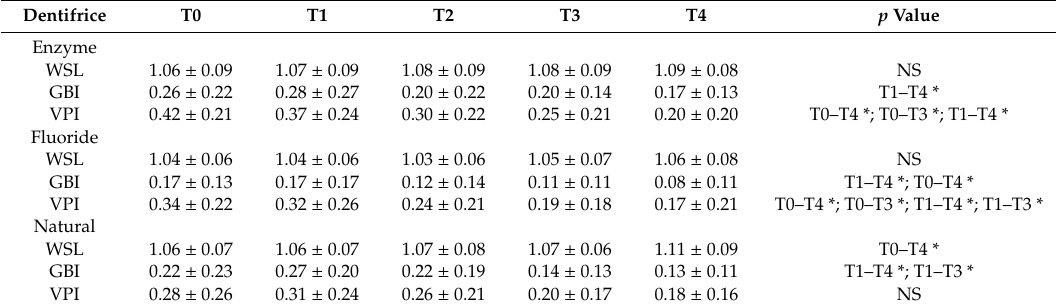
Table 1. Mean and standard deviation comparisons of white spot lesion index (WSL), gingival bleeding index (GBI), and visible plaque index (VPI) in groups 1, 2, and 3 through repeated measures